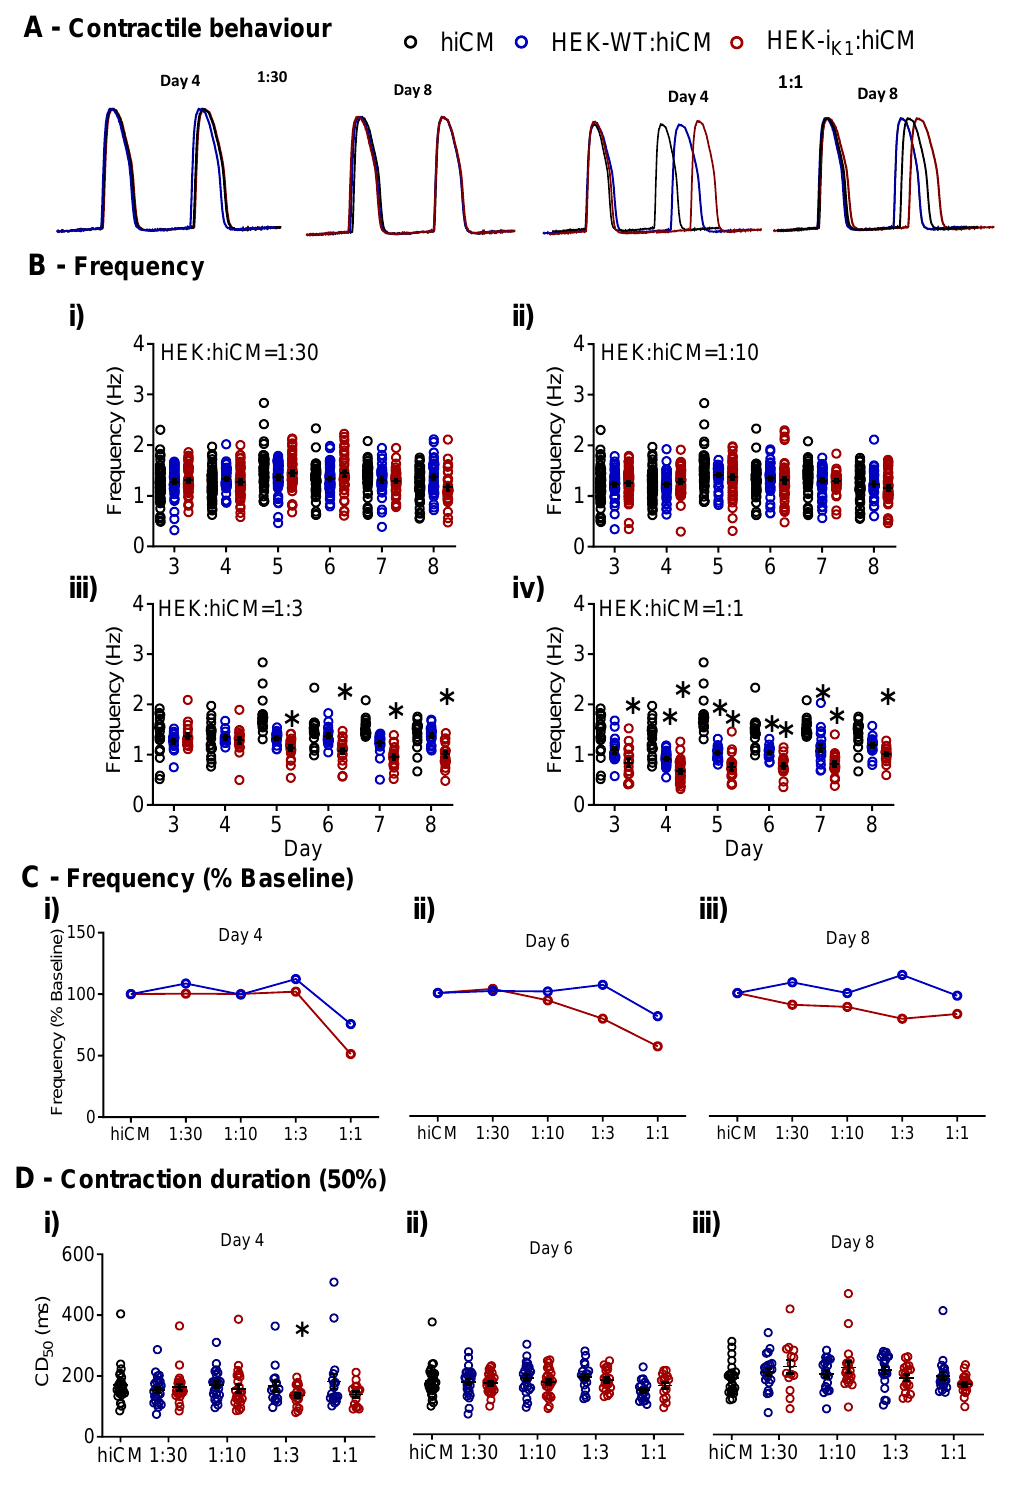
Figure 1. The effects of co-cultures of hiCMs with increasing densities of HEK, for both HEK-I K1 :hiCM and HEK–WT:hiCM. ( A ) Example traces of the effects of 1:30 and 1:1 at days 4 and 8. ( Bi ) Frequency of spontaneous contraction at days 4 to 8 with the ratio 1:30; ( Bii ) frequency at the 1:10 ratio; ( Biii ) frequency at the 1:3 ratio; ( Biv ) frequency at the 1:1 ratio; ( C ) frequency as a percentage from baseline (standard hiCM culture) for the range of ratios. ( Ci ) Day 4; ( Cii ) day 6; ( Ciii ) day 8. ( D ) Contraction duration (CD50) on days 4, 6 and 8 comparing hiCM culture, HEK–WT:hiCM and HEK-I K1 :hiCM. One-way ANOVA with Bartlett’s test, * p < 0.05, n = 51 wells.